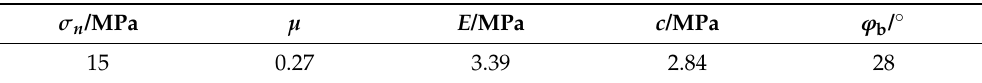
Table 1. Basic mechanical properties that were determined for